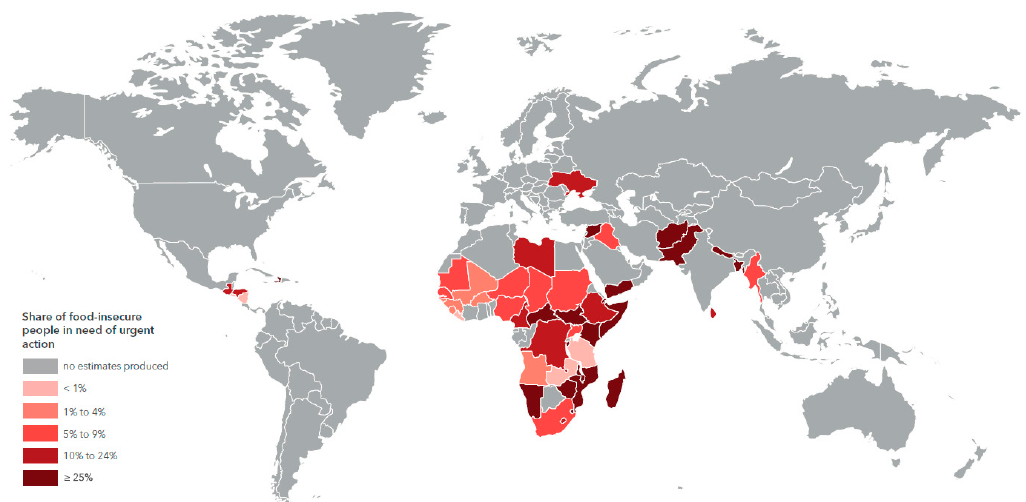
Figure 2. Share of people in Integrated Food Security Phase Classification (IPC)-Cadre Harmonisé (CH) Phase 3 (Crises), Phase 4 (Emergency) and Phase 5 (Famine/Catastrophe) in 2017. Source: Food Security Information Network FSIN [49], Integrated Food Security Phase Classification IPC [50].